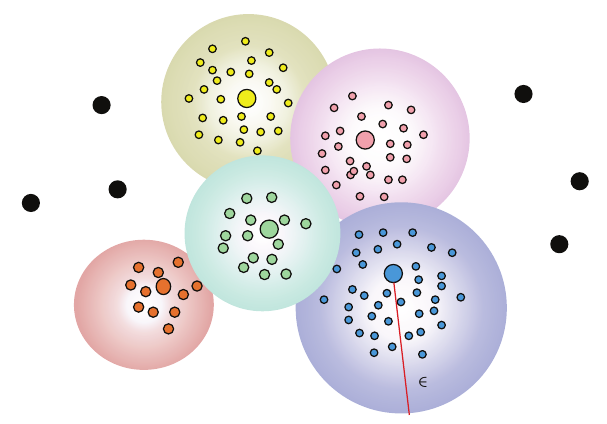
Figure 4: A sketch of DBSCAN algorithm.